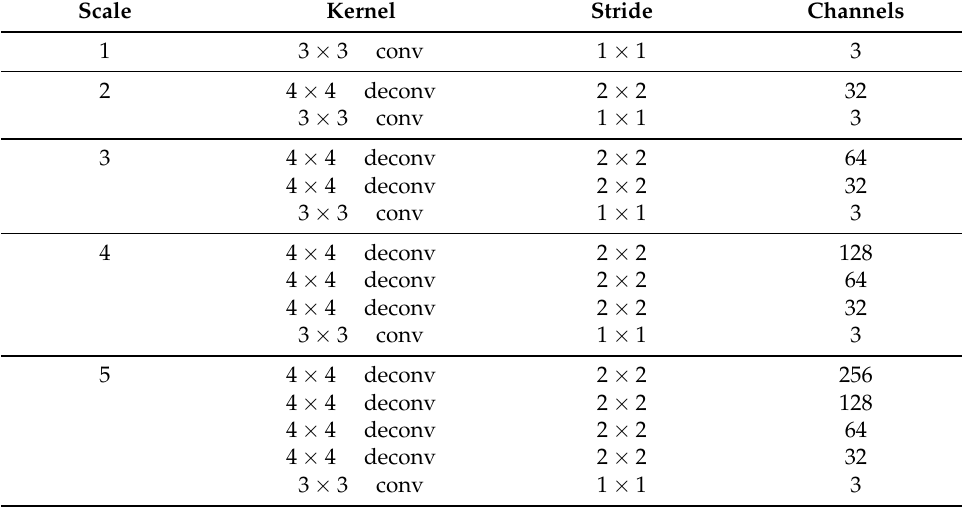
Table 3. Up-sampling